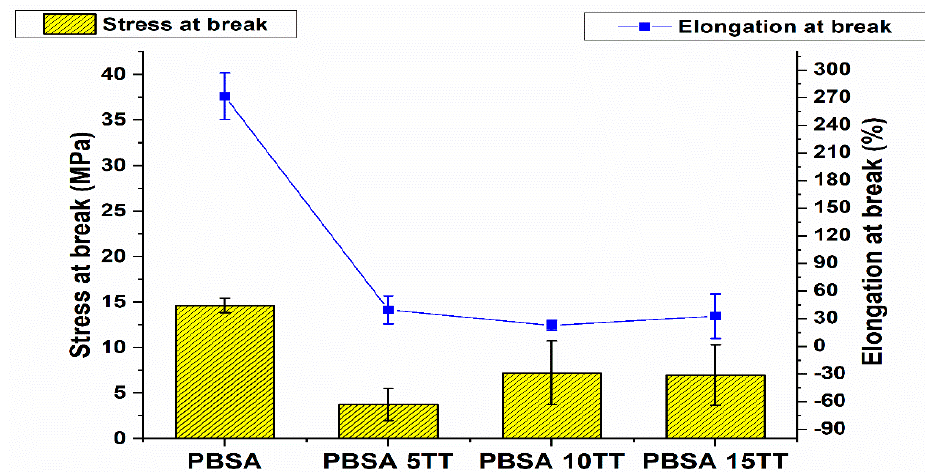
Figure 3. Tensile strength and maximum strain at break of pure virgin PBSA and biocomposites.